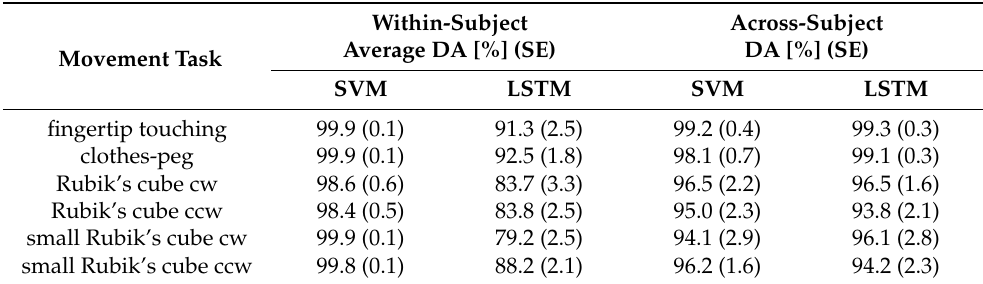
Table 1. Sensitivity of single